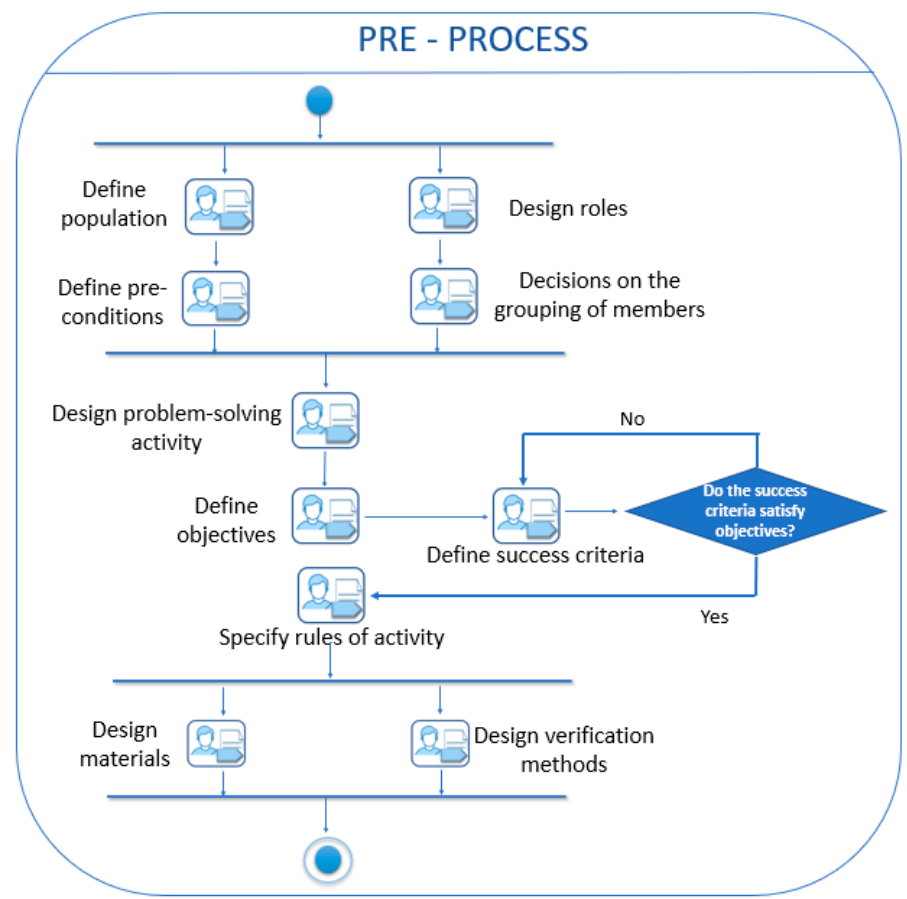
Figure 2. Workflow of pre-process activities.